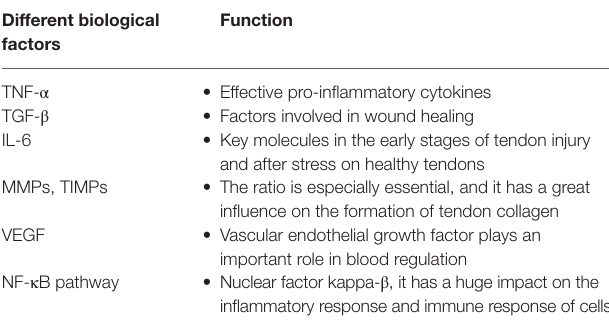
TABLE 3 | The role of diverse